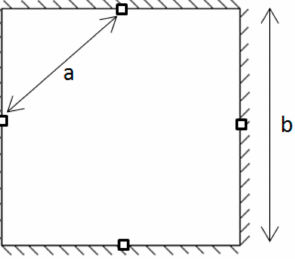
Figure 5. Schematic of the equivalent model when calculate the Euler stress.